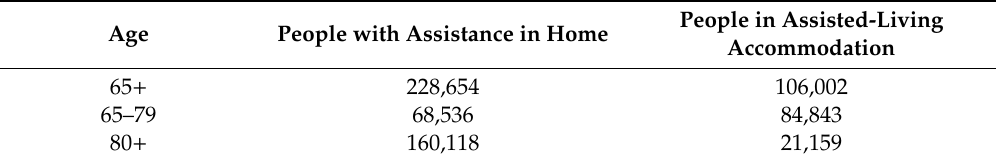
Table 1. Number of people with assistance in their own home and number of people living in assisted-living accomodation in Sweden (men and women; 2016)